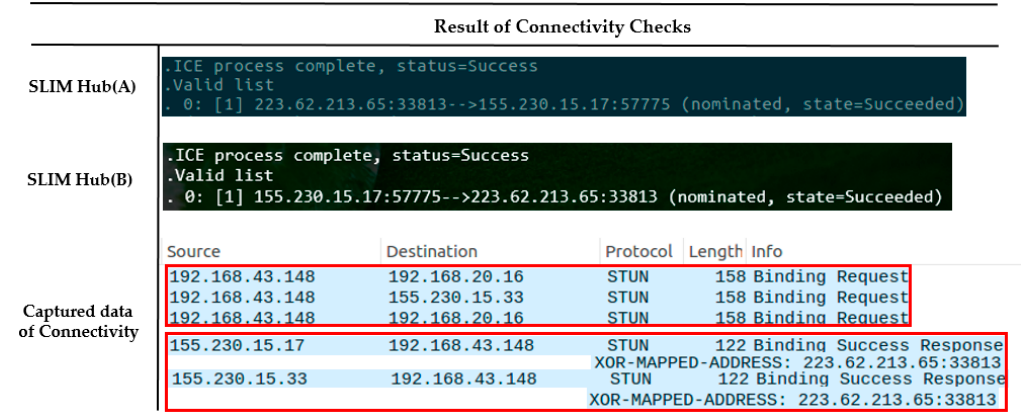
Figure 22. Connectivity checks in different private networks.